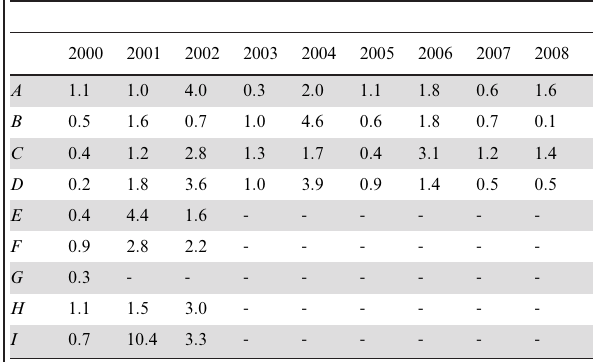
Table 2. Nymphs to total ticks ratio for observed feeding ticks on